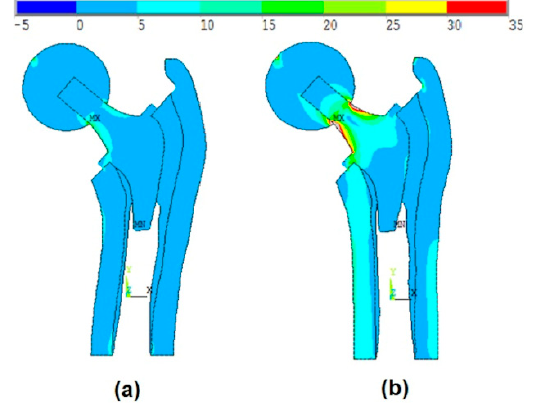
Figure 11. The effect of the introduction of the ball, bone anisotropy, and the stem shape optimization on the von-Mises stress distribution at ( a ) the optimal point and ( b ) the failure point.